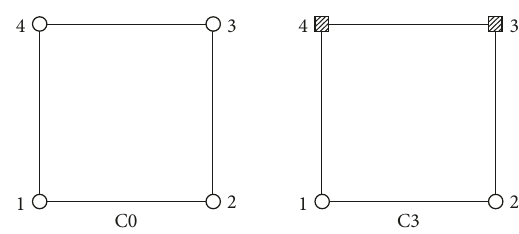
Figure 12: Four-column frame: different deployments of the sliding devices: circle normal friction coefficient and square (cid:31) friction coefficient.